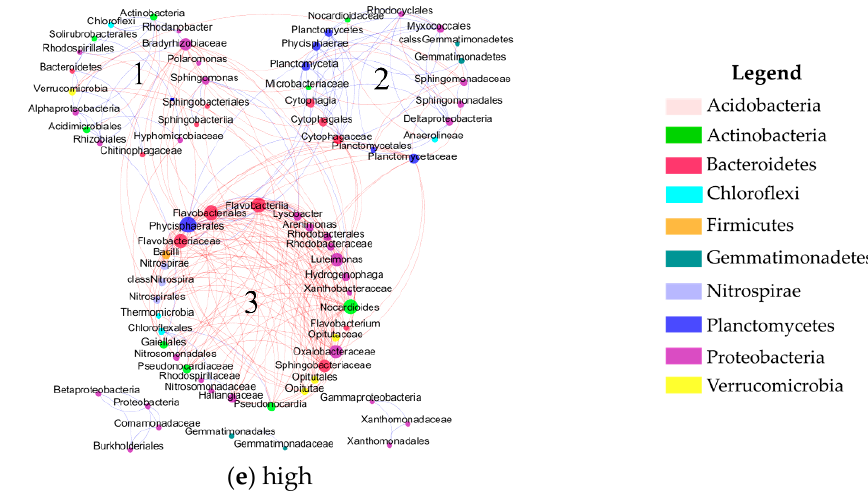
Figure 3. Network graph with module structure produced by the fast greedy modularity optimization method. Each node corresponds to a microbial population: ( a ) network C; ( b ) network L; ( c ) network M; ( d ) network H; ( e ) network E. 1, 2, 3 and 4 stand for the module number. A red link indicates a negative correlation and a blue link positive correlation.